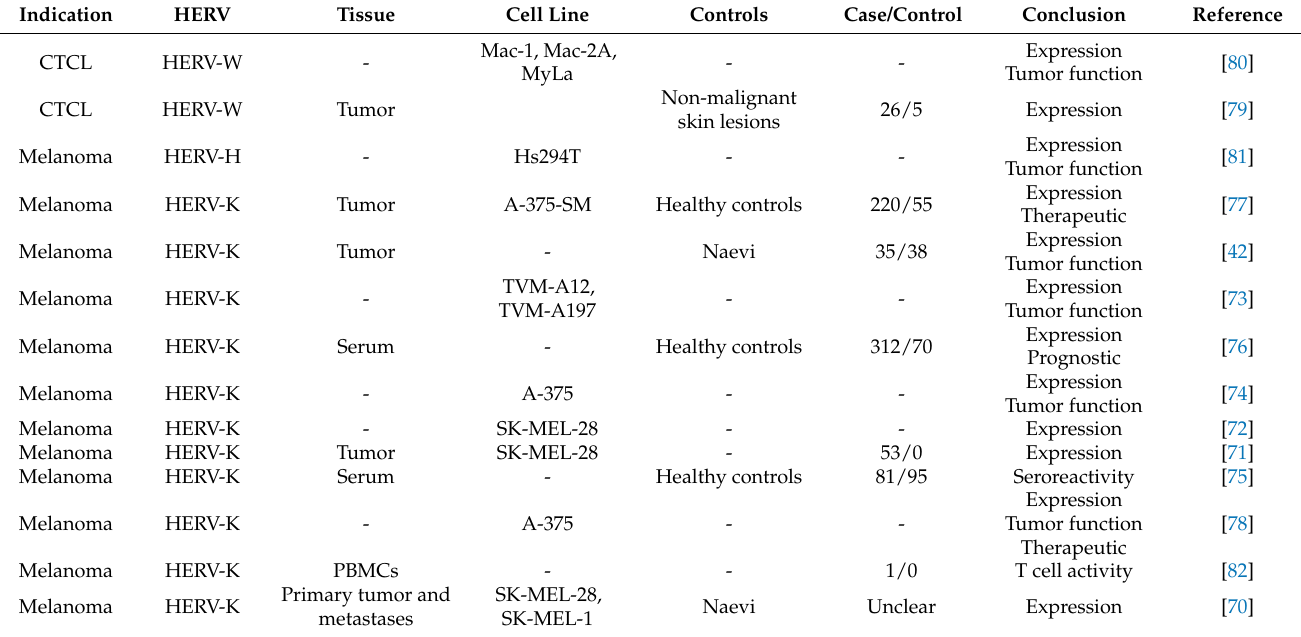
Table 3. HERV protein expression in skin